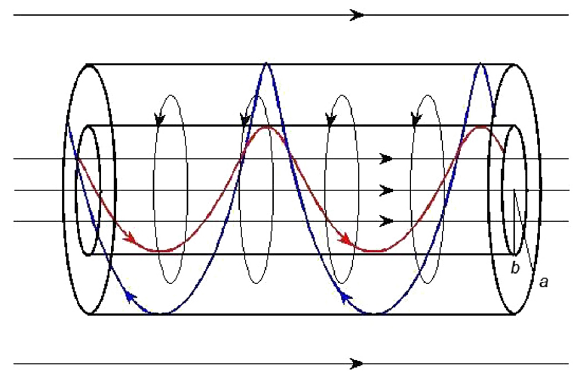
Figure 1. A complex magnetic-flux tube with two surface electric currents. The blue helical curve shows a current line on the external surface of the annulus, while the red helical curve shows a current line on the internal surface of the annulus.